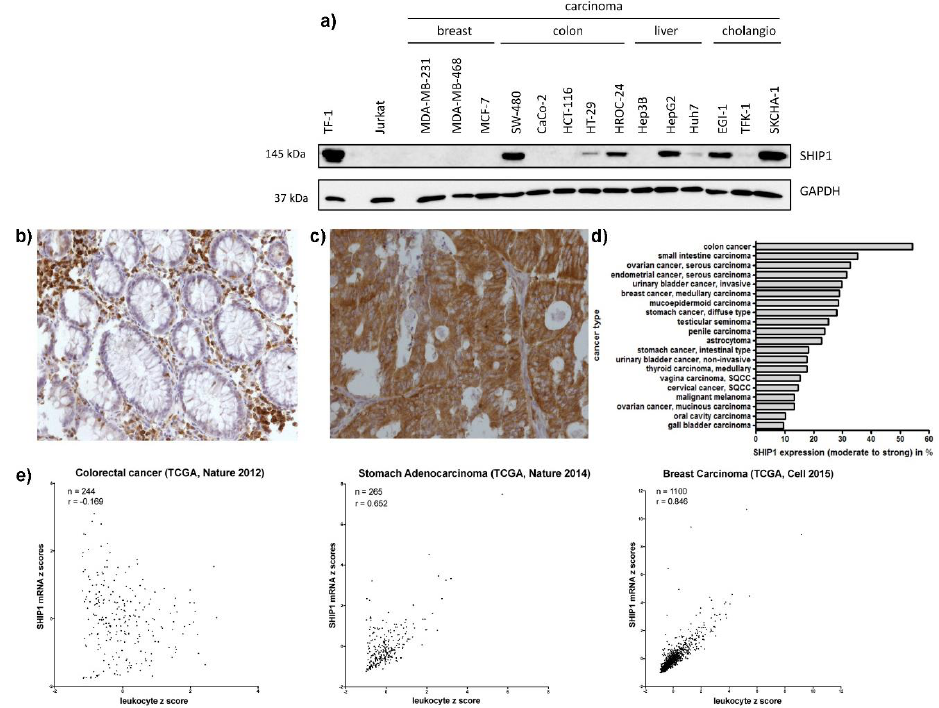
Figure 1. Expression of SHIP1 in carcinomas and sarcomas. ( a ) Lysates from indicated cell lines were electrophoretically separated using SDS-PAGE, and a Western blot was performed with monoclonal antibodies against SHIP1 and GAPDH. ( b , c ). Human tissue samples spotted on a multi-tumor tissue microarray were stained for SHIP1 via immunohistochemistry. Representative images of SHIP1 immunohistochemistry in colon tissues taken at 100 × magnification are shown. Positive SHIP1 staining in lymphocytes of normal colon tissue was observed, while epithelial cells were negative ( b ). Strong SHIP1 staining was detected in colon cancer cells ( c ). ( d ) Twenty cancer types and subtypes with the highest frequency of moderate to strong SHIP1 expression are shown. Only cancers with at least ten specimens were included. ( e ) Publicly available RNA Seq expression data from The Cancer Genome Atlas (TCGA) was used to analyze SHIP1 expression on the RNA level. SHIP1 mRNA expression from a colorectal cancer, stomach adenocarcinoma and breast carcinoma dataset was correlated with a set of leukocyte markers (see Section 2.5), showing that SHIP1 mRNA expression is independent of leukocyte marker expression in colorectal cancer but not in breast